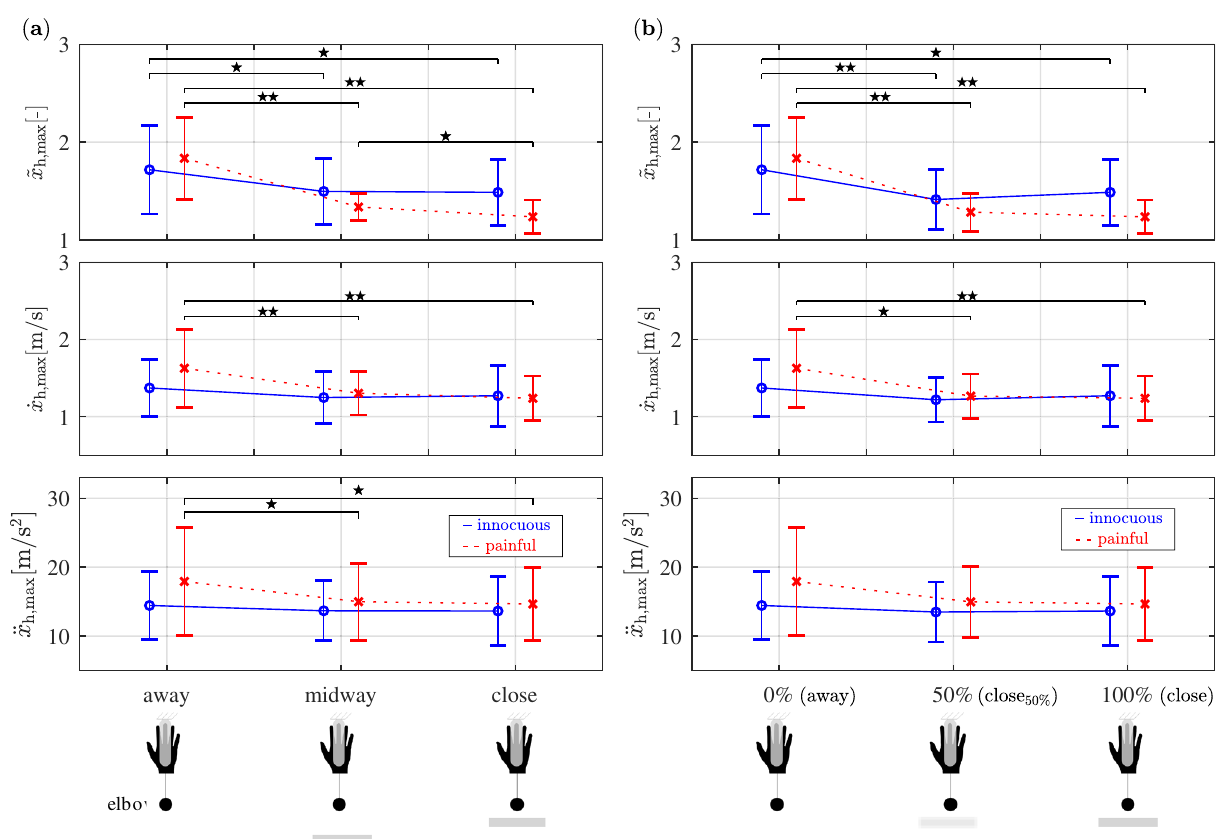
Figure 3. ( a ) Maximum hand retraction ˜ x h,max (1), ˙ x h,max and ¨ x h,max over varying obstacle distances { away , midway , close } , for both innocuous (blue) and painful (red) groups. The closer the wall, the less the hand retracts. This effect is more remarkable for obstacle type painful (red). Only when the painful obstacle is presented (red), subjects slow down speed and decrease acceleration of hand retraction. ⋆ = p < 0.05